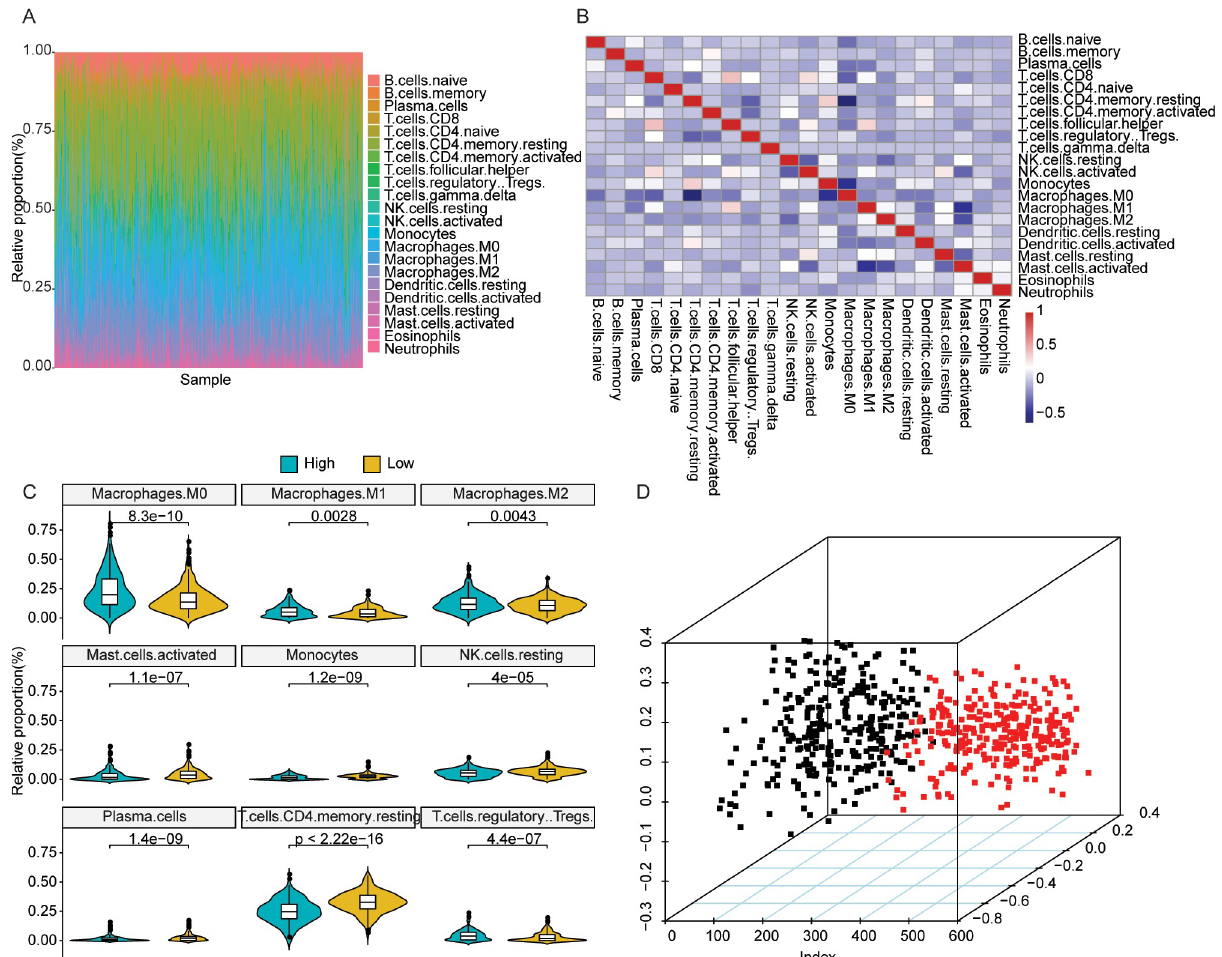
Fig 4. Immune infiltration of CRC patients with different risk scores. (A) Landscape of relative proportions of 22 TIICs across all of the CRC samples. (B) Correlation analysis of 22 TIICs. Red: positive correlation; Blue: negative correlation; Great correlation was represented by dark color. (C) Relative proportions of 9 TIICs exhibiting significantly different infiltrating degree between CRC samples with different risk scores. (D) PCA plot of CRC samples based on the relative proportions of the 9 significantly different TIICs.